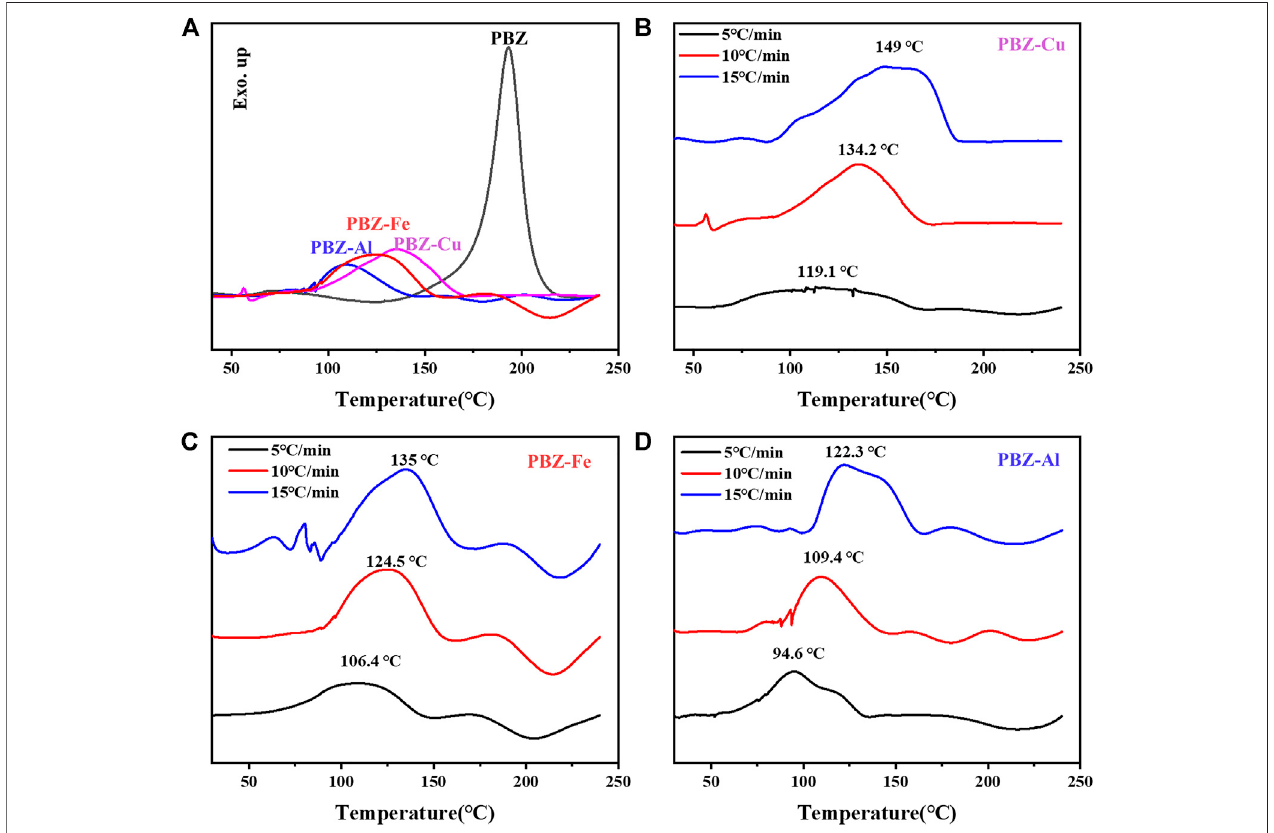
FIGURE 2 | (A) Thermal curing behavior of BZ and BZ/MCl x . (B – D) the curing kinetics of BZ/MCl x at different rates ( β = 5, 10, 15 ° C min − 1 ).